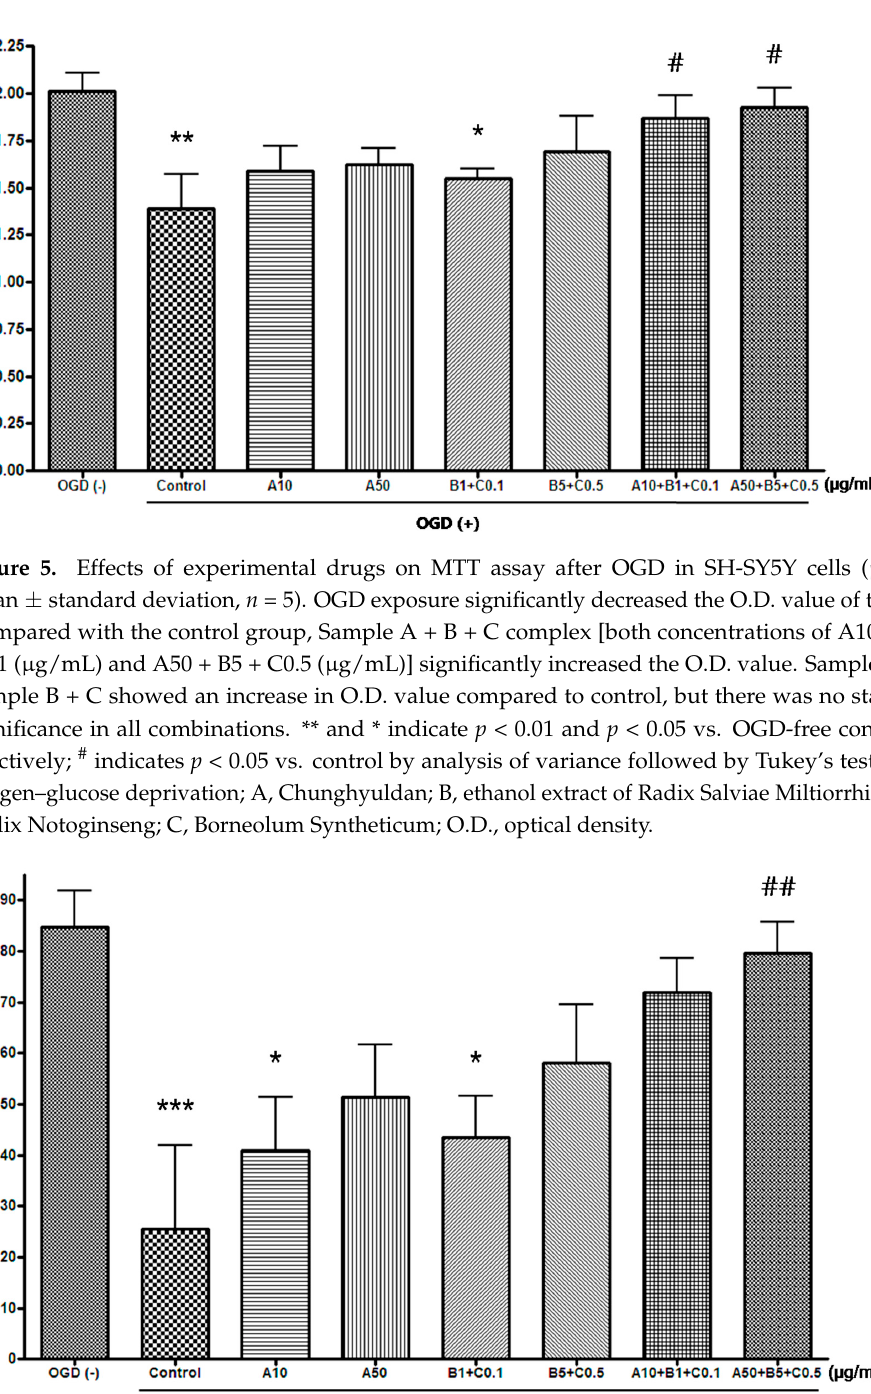
Figure 6. Effects of the experimental drugs on OGD-induced cell death by cell count experiment in SH-SY5Y cells. ( µ g/mL, mean ± standard deviation, n = 5). OGD exposure significantly reduced the number of live cells. Compared with OGD-treated control groups, Sample A + B + C complex (A50 + B5 + C0.5 [ µ g/mL]) significantly increased the cell viability compared with the control group. Sample A and Sample B + C showed an increase in cell viability compared to control, but there was no statistical significance in all combinations. *** and * indicate p < 0.001 and p < 0.05 vs. OGD-free control, respectively; ## indicates p < 0.01 vs. control by analysis of variance followed by Tukey’s test. OGD, oxygen–glucose deprivation; A, Chunghyuldan; B, ethanol extract of Radix Salviae Miltiorrhizae and Radix Notoginseng; C, Borneolum